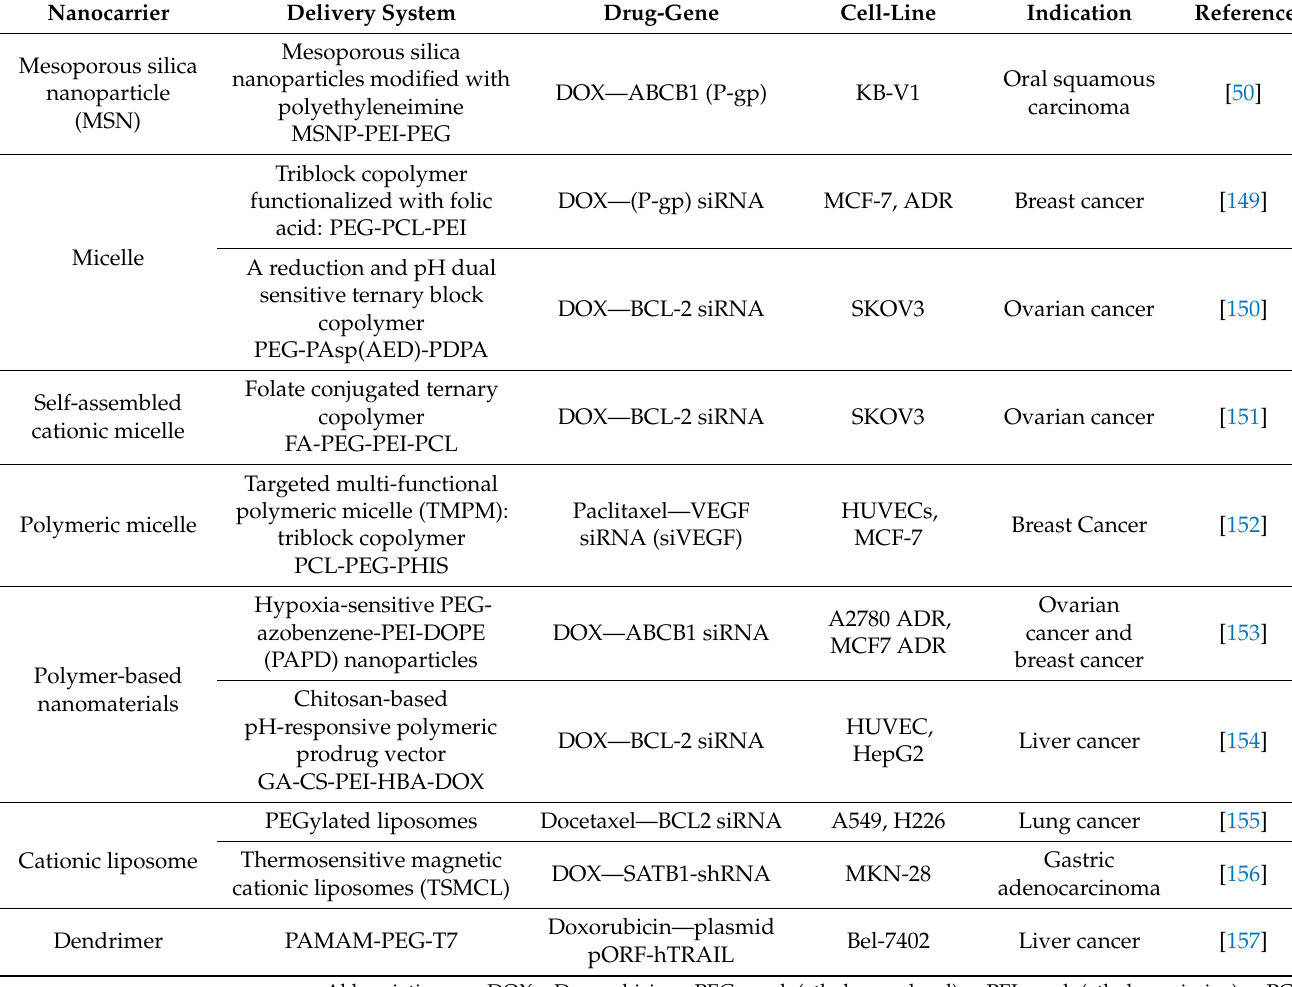
Table 4. Co-delivery of small molecule drugs and therapeutic genes for cancer